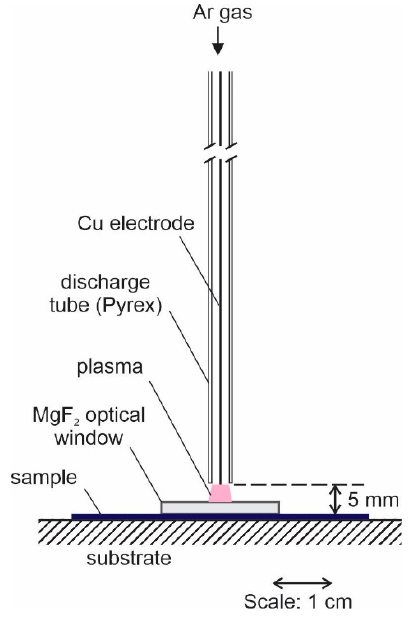
Figure 1. Schematic illustration of the experimental setup.